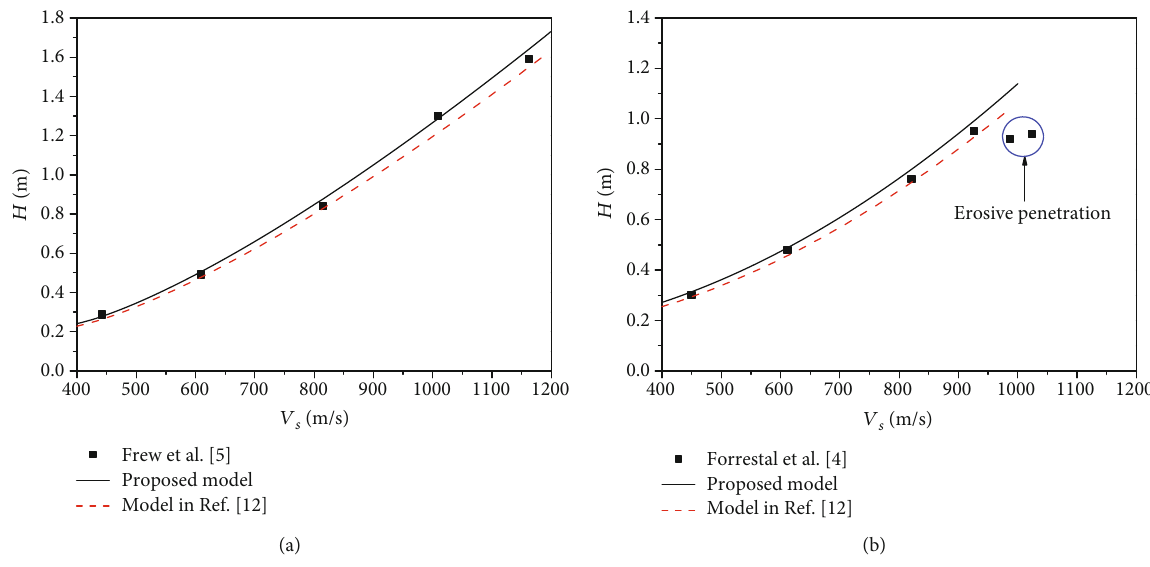
Figure 7: Comparison of predicted and experimental DOP for (a) 58.4MPa and (b) 62.8MPa